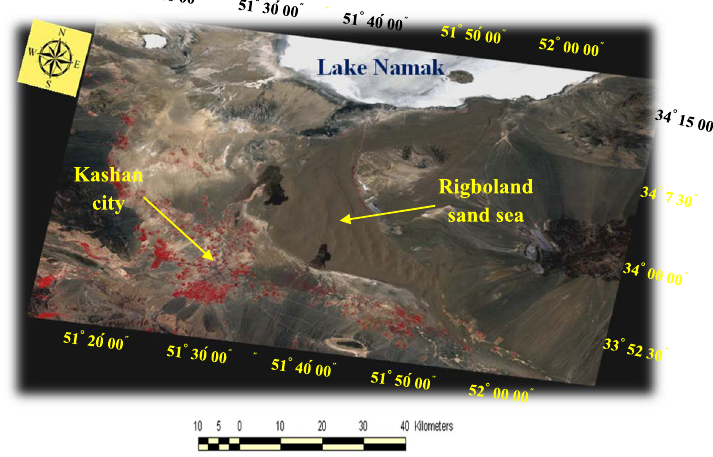
Figure 3. The Landsat TM image of the Rigboland sand sea and surrounding areas with geometry and atmospheric corrections plus radiometric calibration (ENVI software version